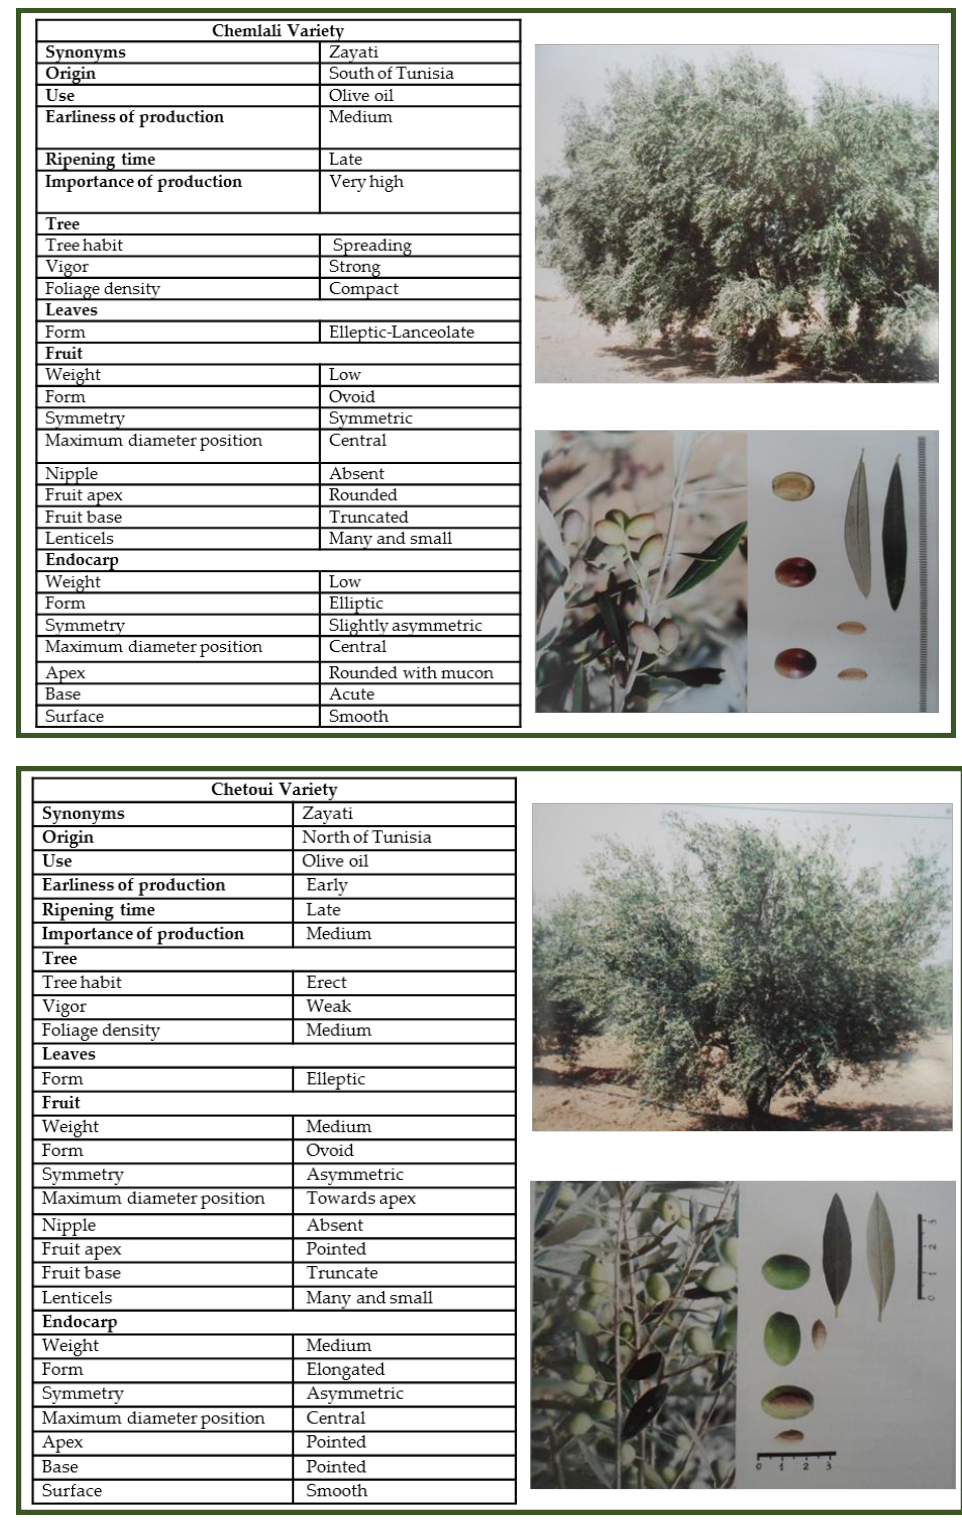
Figure 2. Description and passport data of most cultivated Tunisian varieties Chetoui and Chem- lali, as described by Trigui and Msallem